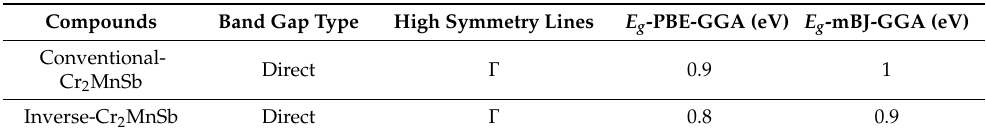
Table 6. The energy band gaps for conventional and inverse Cr 2 MnSb compound using PBE-GGA and mBJ methods.